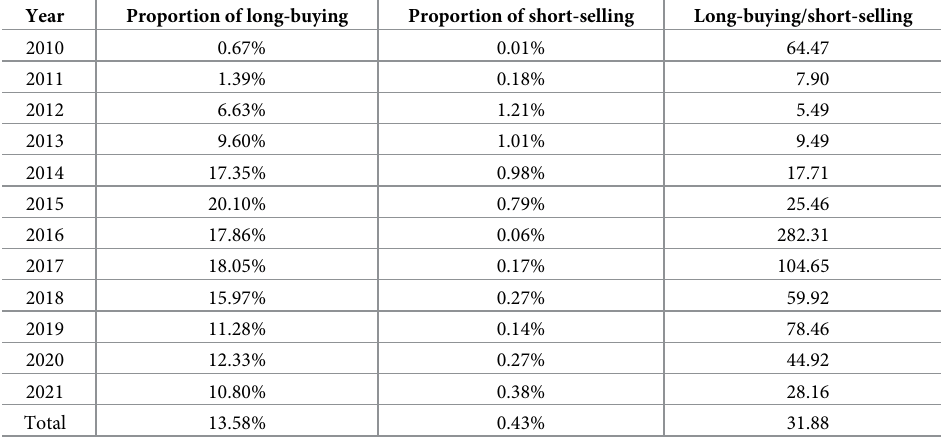
Table 4. Proportion of margin